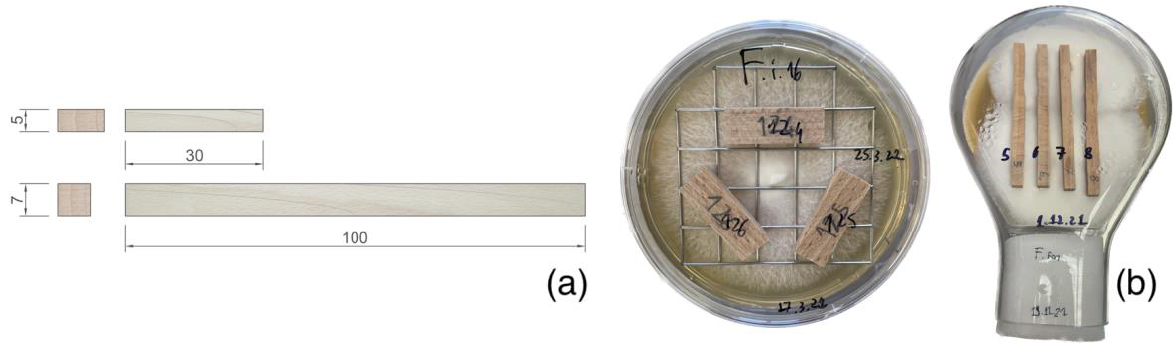
Figure 1. Front and lateral faces of crafted specimens for mass-loss assessment and mechanical testing ( a ); fungal exposure in Petri dishes and Kolle culture flasks ( b ). The moisture content ( MC ), green density ( ρ w ), basic density ( ρ c ), and ML were calcu- lated from sample dimensions and both dry and wet (before and after degradation) masses.